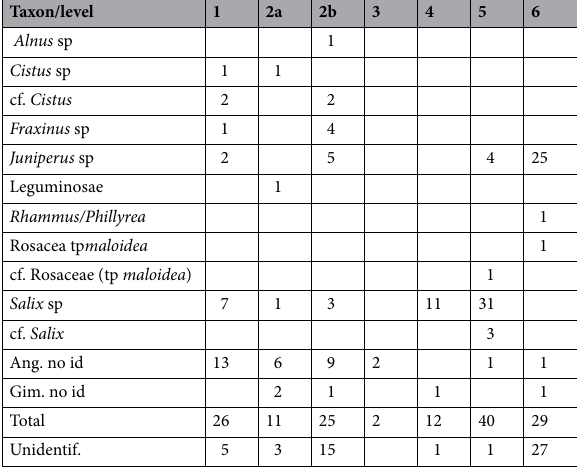
Table 2. Wood charcoal identified in Peña